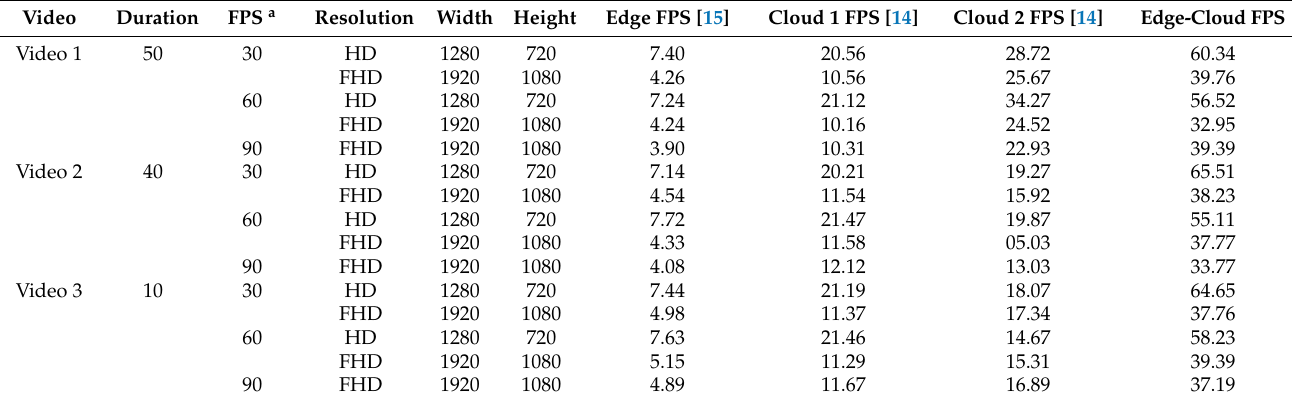
Table 1. Results for each deployment for the fifteen input